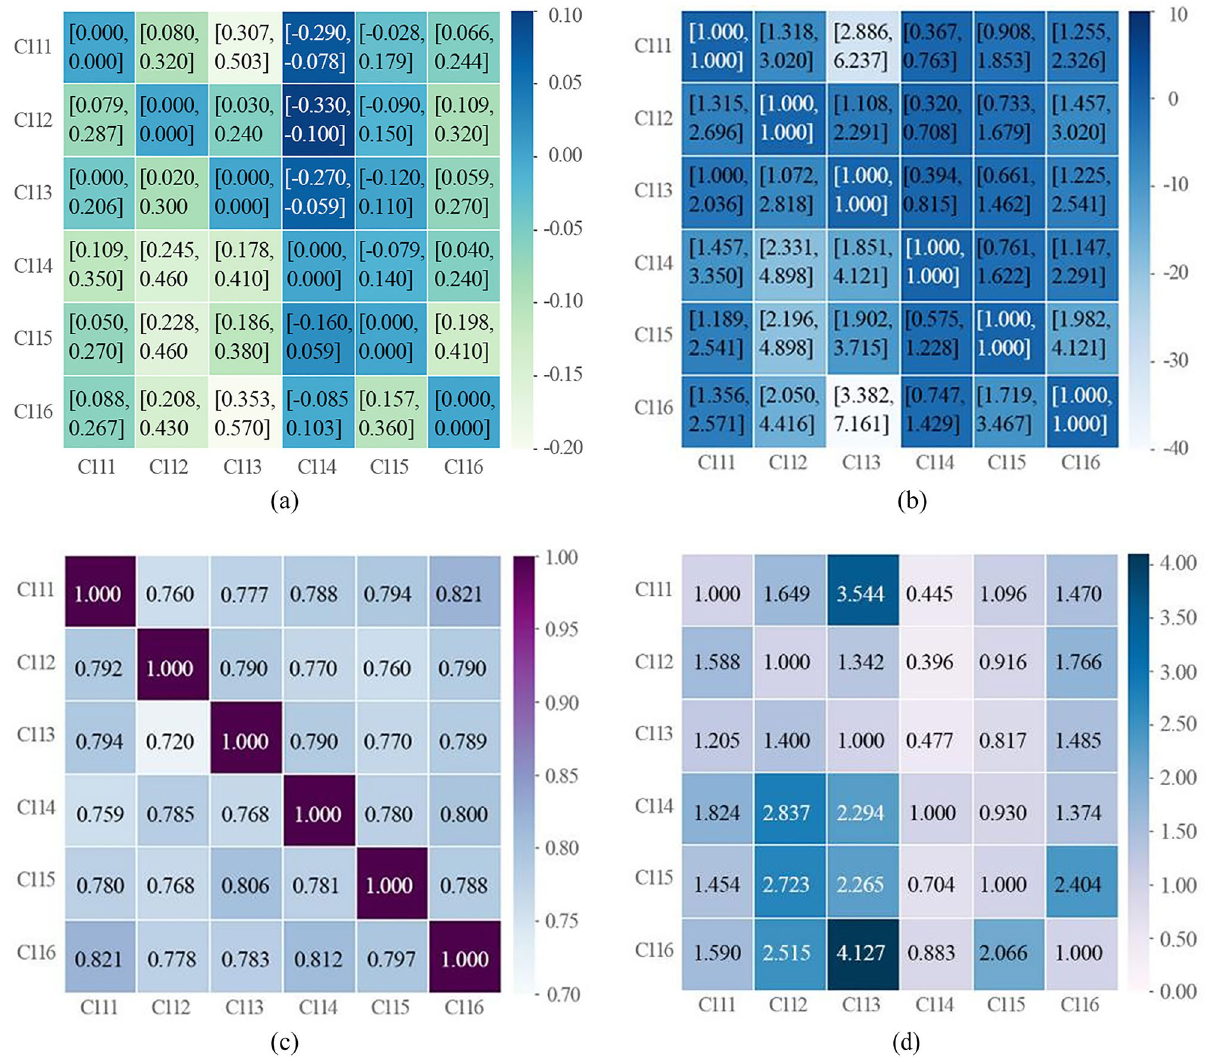
Figure 4. Matrix diagram: ( a ) difference matrix, ( b ) interval multiplication matrix, ( c ) deterministic value matrix, ( d ) weight matrix before normalization.